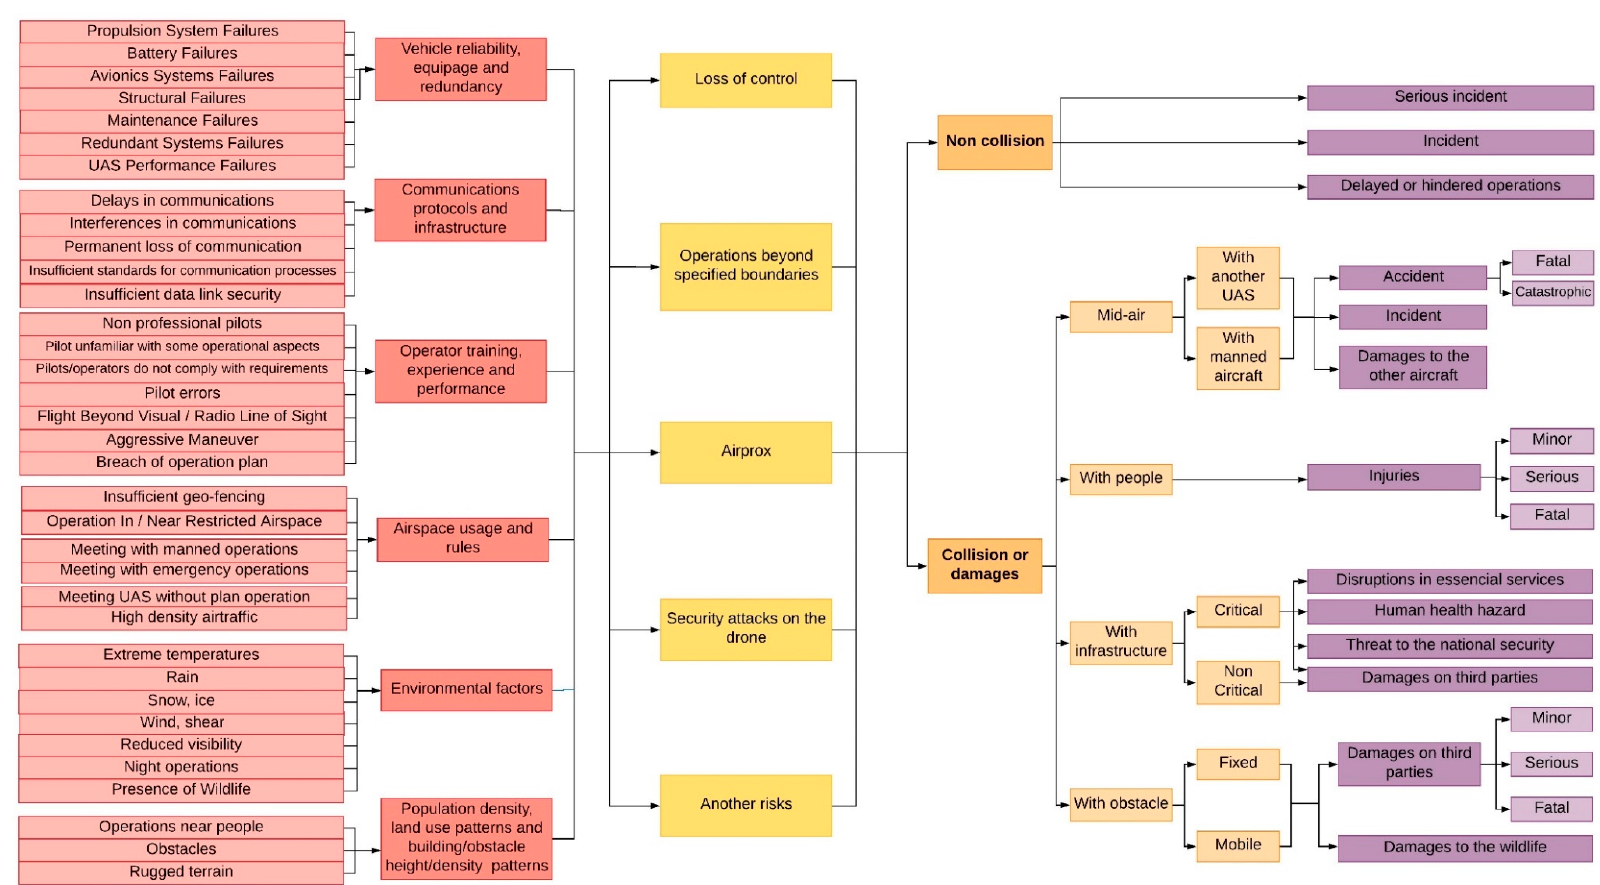
Figure 1. Hazards and risk analysis based on the fault tree structure.